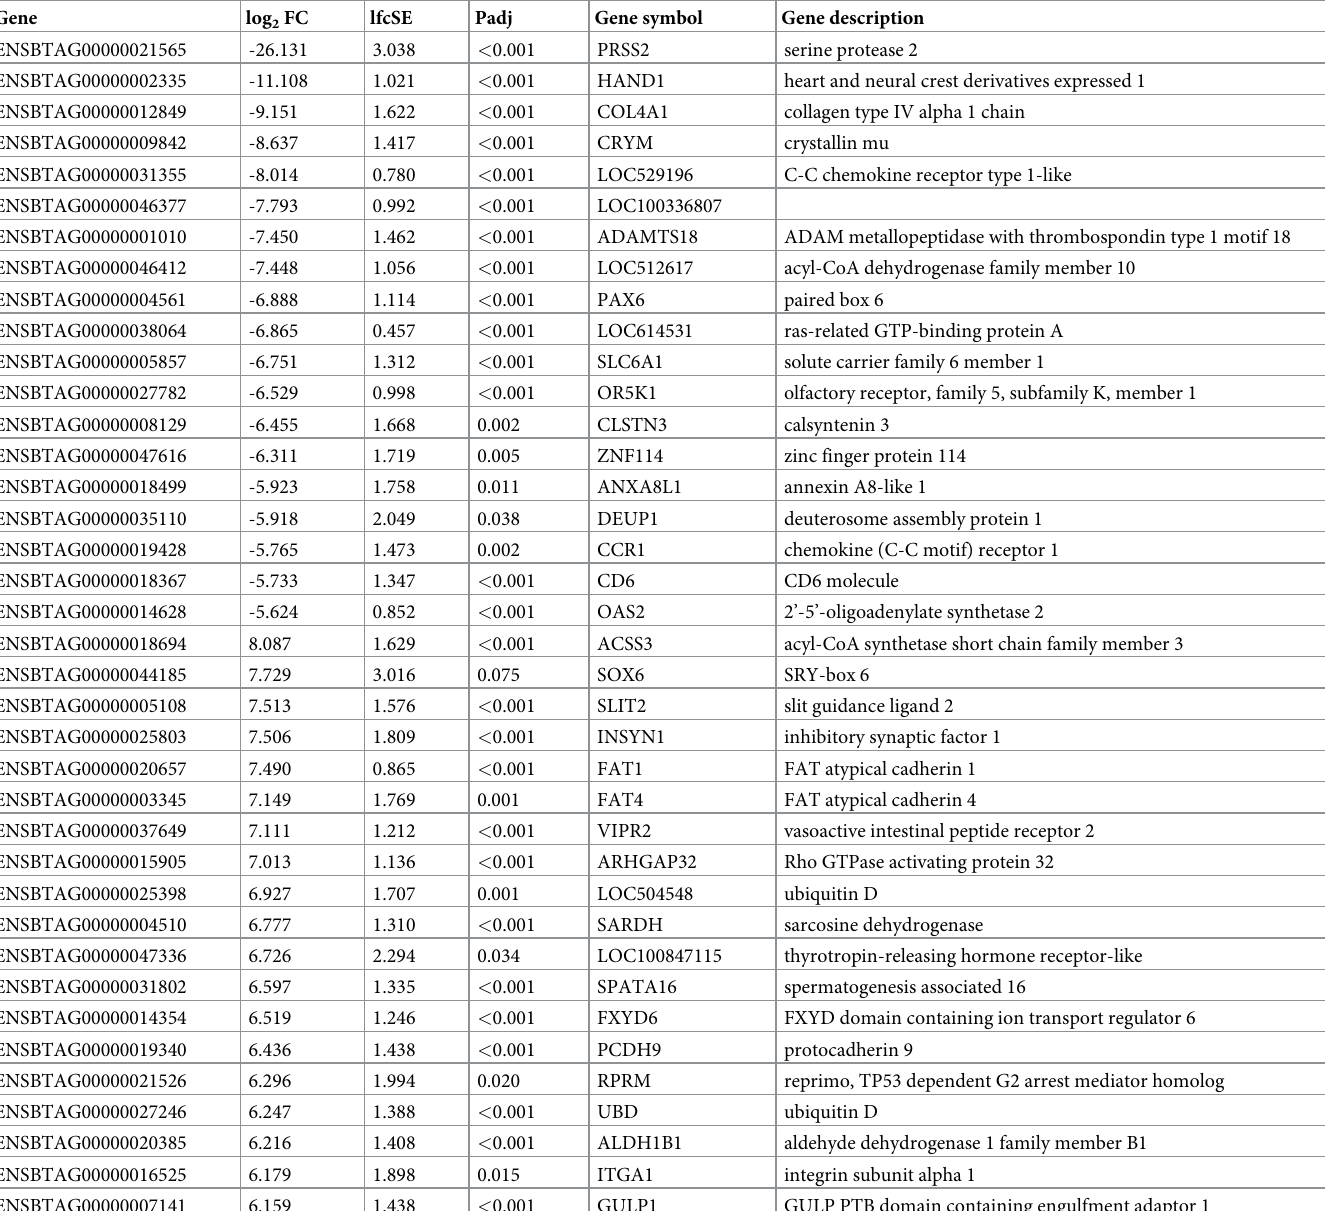
Table 1. Top 19 (by Log 2 fold change) down- and up-regulated genes in B . taurus vs . B . indicus T . annulata infected cell